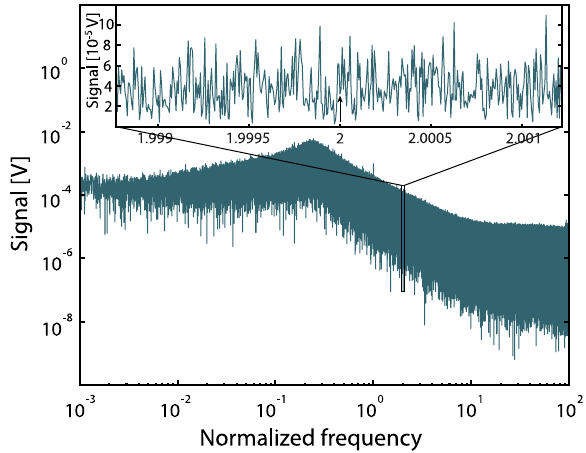
FIG. 3. Fourier transform of 120 h of data. Frequency is measured in multiples of the turntable rotation frequency. The inset shows the region around the expected signals.